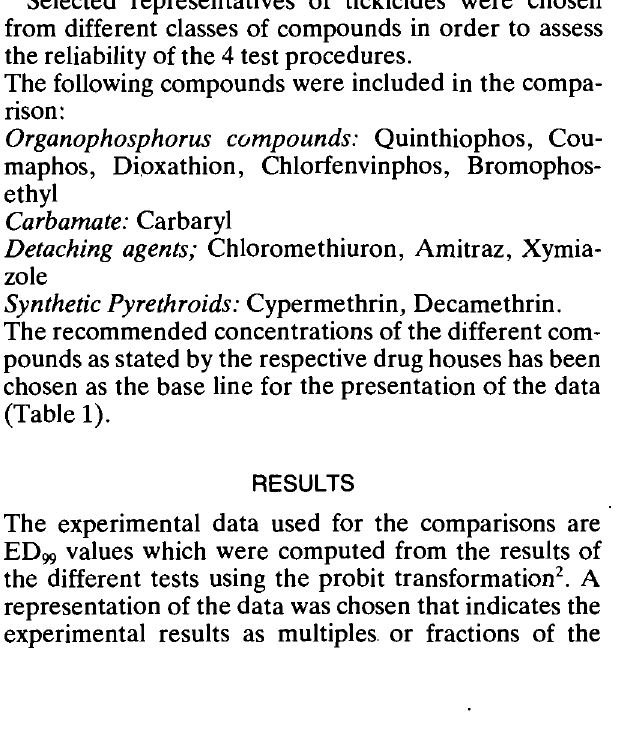
Fig. 1 Boophilus microp/us (sens. Yeerongpilly-Strain)/Organophosphorus compounds. Results of different tests (EDgg) compared with the recommended concentration